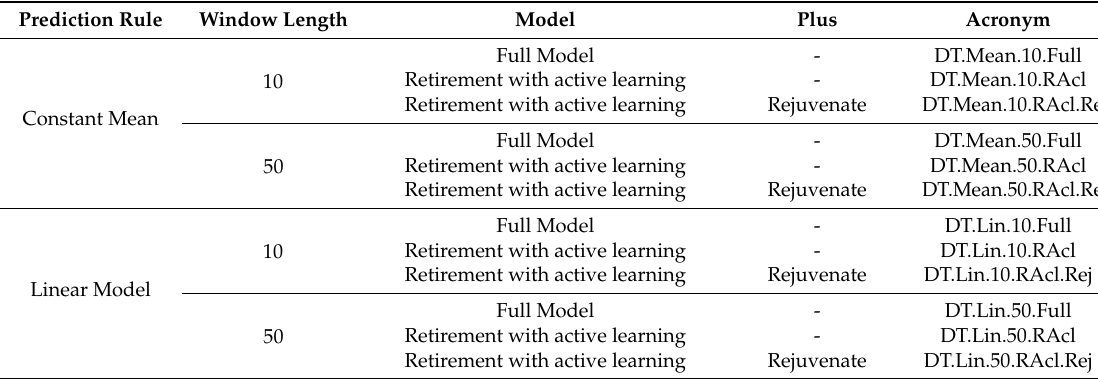
Table 6. Acronyms of the final DT methods to be